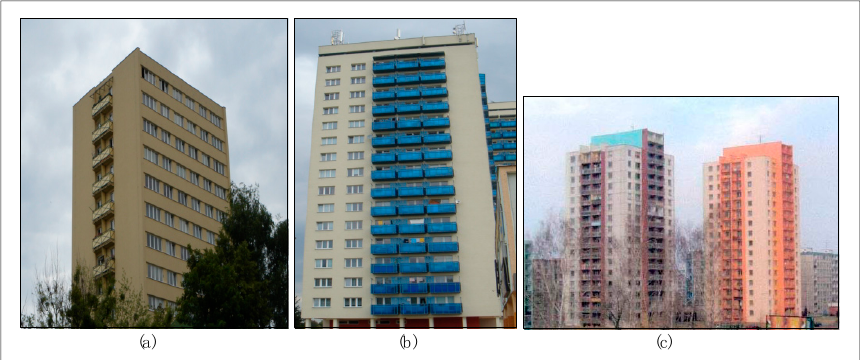
Figure A3. Prefabricated residential housing buildings after the renovation intervention by ETICS: